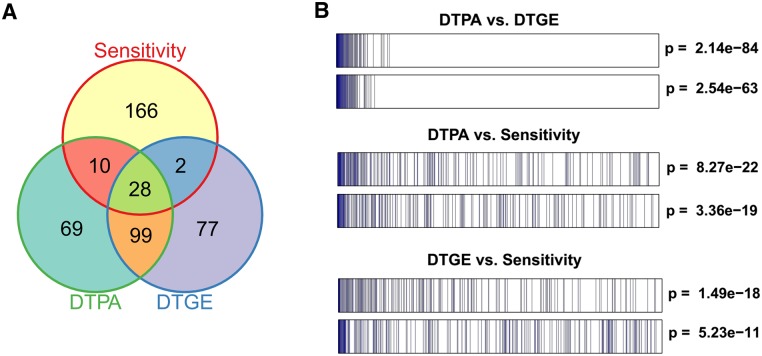
Comparison of CMoA, GES and GI50 profile similarities.(A) Venn diagram of the top 206 similar compound pairs (top 2.5%) using DTPA, DTGE and GI50 sensitivity profiles. (B) top: Enrichment of the top 206 pairs based on DTPA similarity in the vector of 8256 (129*128/2) compound pairs ranked by DTGE similarity, and vice versa; middle: Enrichment of the top 206 pairs based on DTPA similarity in the vector of 8256 (129*128/2) compound pairs ranked by GI50 correlation, and vice versa; bottom: Enrichment plot of the top 206 pairs using DTGE similarity in the vector of 8256 (129*128/2) compound pairs ranked by GI50 correlation, and vice versa.